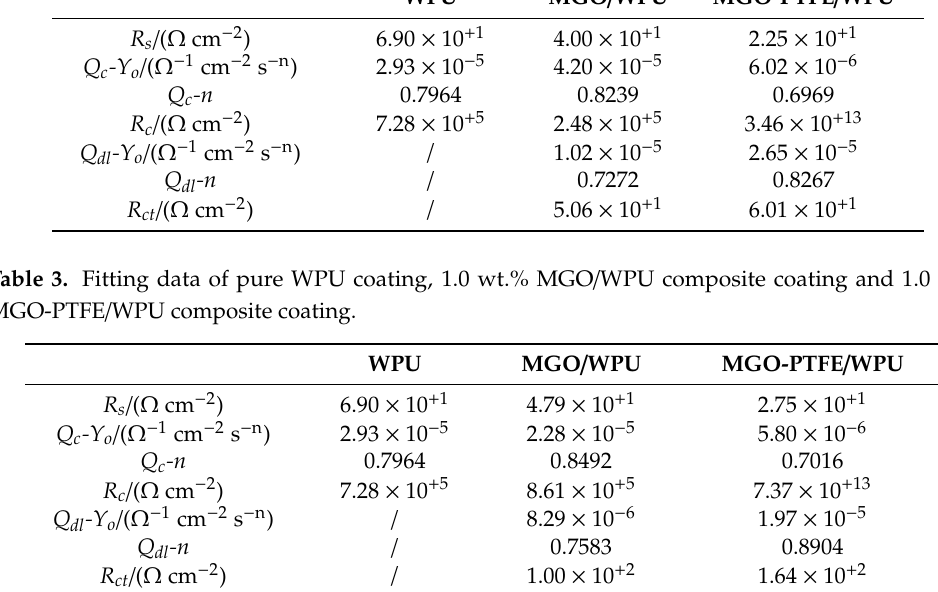
Table 4. Fitting data of pure WPU coating, 1.5 wt.% MGO/WPU composite coating and 1.5 wt.% MGO-PTFE/WPU composite coating.